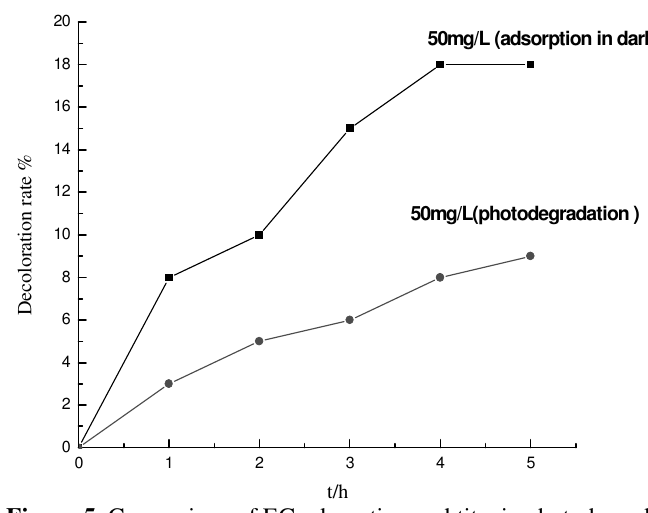
Figure 5. Comparison of EG adsorption and titania photodegradation